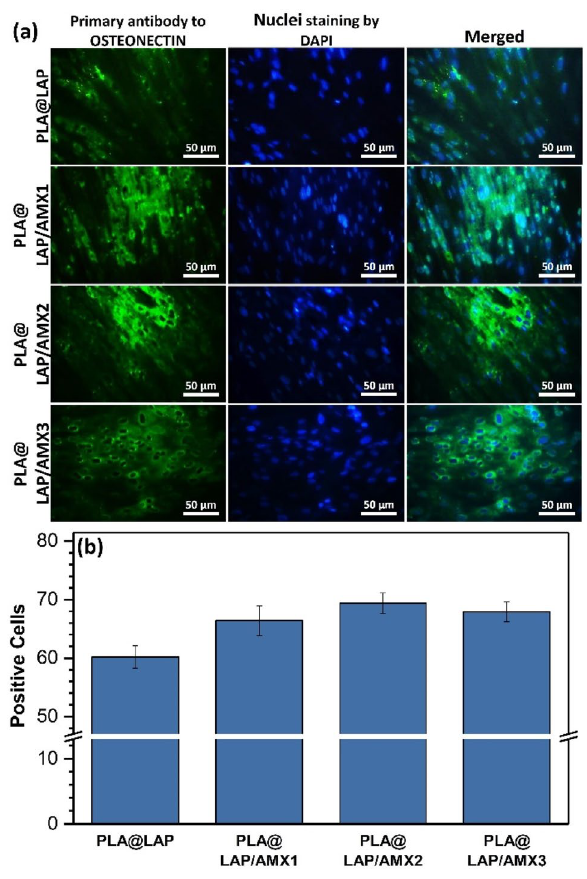
Figure 8. ( a ) ICC images for expression of OSTEONECTIN protein in hBMSCs cultured on scaffolds after 21 days of incubation. ( b ) Quantification of ICC images with Image J software (n =